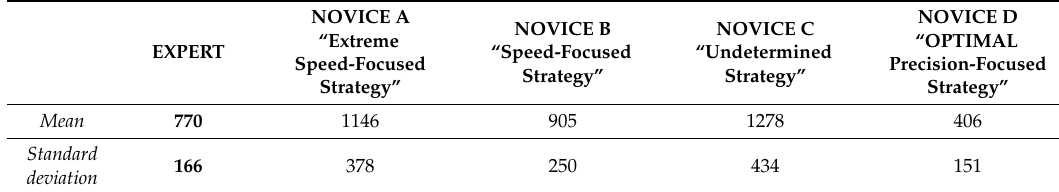
Table 4. Expert single session statistics for the parameter relative to task precision (off-target score in pixels) compared with the statistics from the last of eight or ten training sessions of novice trainees A, B, C, and D in the same camera view conditions. Each statistic was computed on a total number of 80 trial